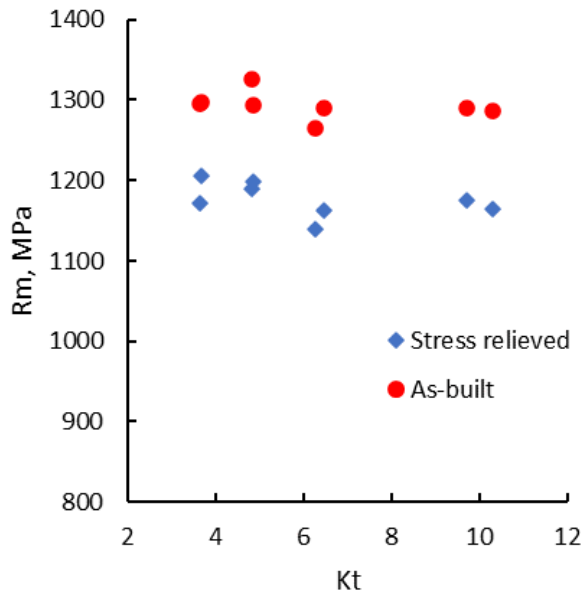
Figure 5. Tensile strength vs. the coefficient of stress concentration.